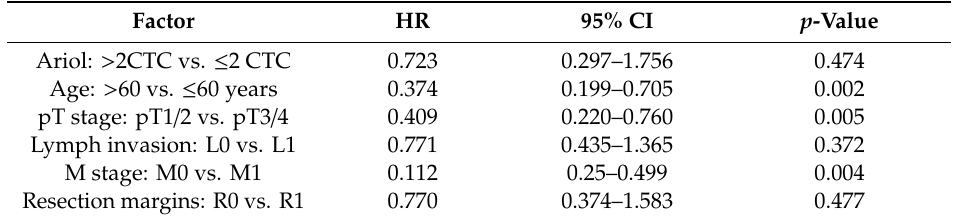
Table 2. Multivariate analysis of overall survival. HR: hazard ratio; CI: confidence interval; CTC: circulating tumor